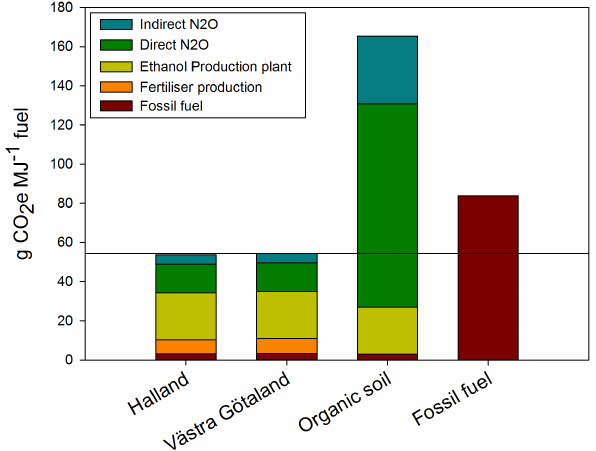
Fig. 1. LCA of greenhouse gas emissions due to production of ethanol from wheat, expressed as carbon dioxide equivalents per MJ ethanol-derived energy. For Halland and V¨astra G¨otaland, max- imum N 2 O-N emissions of 1.5 and 0.5kgNha − 1 yr − 1 for direct and indirect emissions, respectively, are allowed to achieve 35% savings (horizontal line). Wheat production for bioethanol on un- fertilised organic soils with emissions of CO 2 (not included here) and 10kgN 2 O-Nha − 1 yr − 1 would give higher emissions than fos- sil fuels and is shown for comparison. Standard yields for win- ter wheat were 6097 and 5676kgha − 1 for Halland and V¨astra G¨otaland, respectively (14% water content) (Statistics